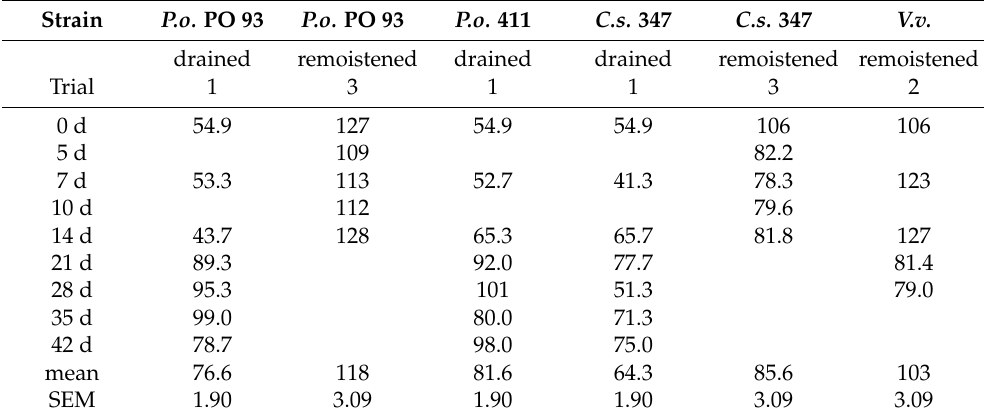
Table 3. Non-fiber carbohydrates (g/kg DM) in the different fungal treatments after varying storage time (d).